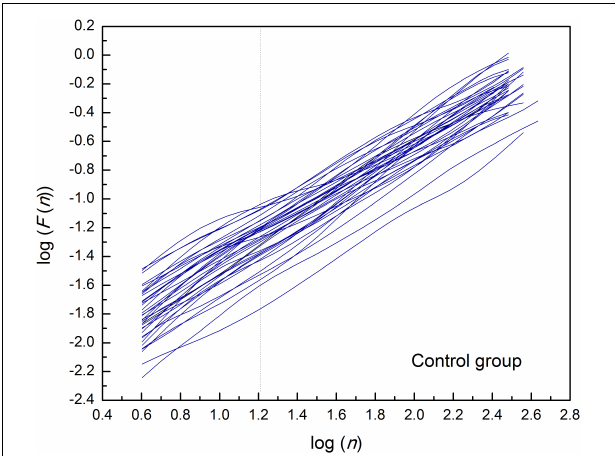
FIGURE 1 | Detrended fluctuation functions F ( n ) for time series of interbeat intervals (approximately N = 1,200 samples) versus segment size n on the log-log graph, in the control group of healthy subjects. Dashed line separates the two ranges in which the scaling exponents have been determined ( n = 16).